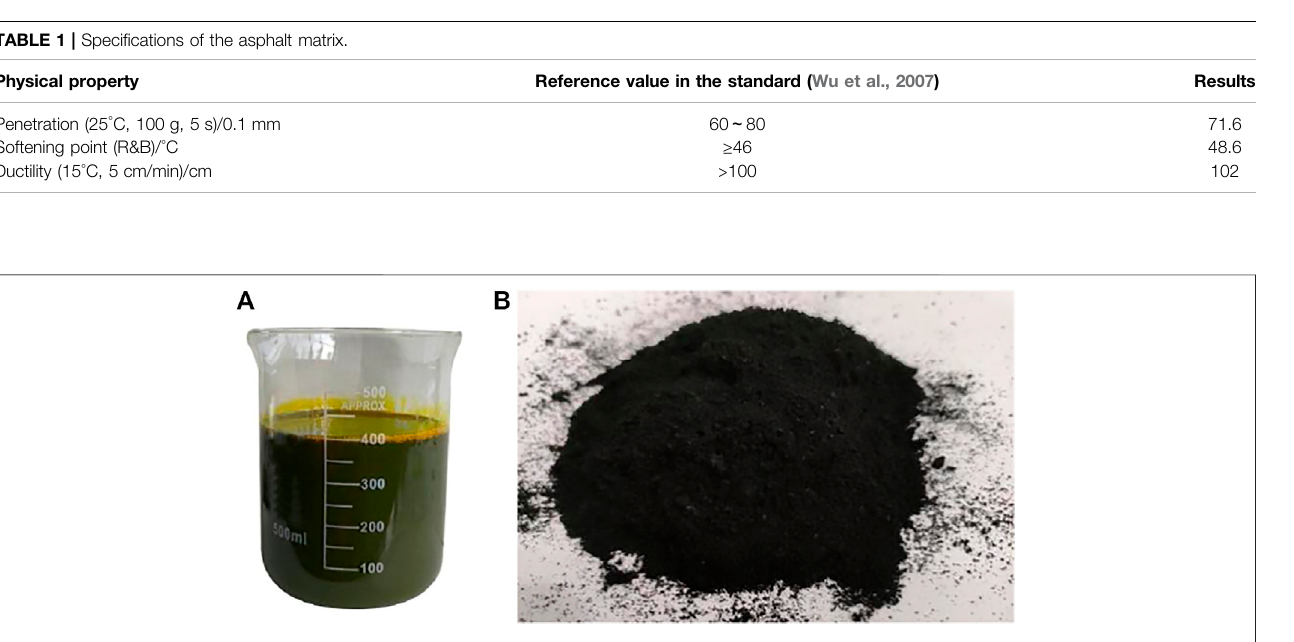
FIGURE 2 | The appearance of aromatic oil (A) and crumb rubber (B)